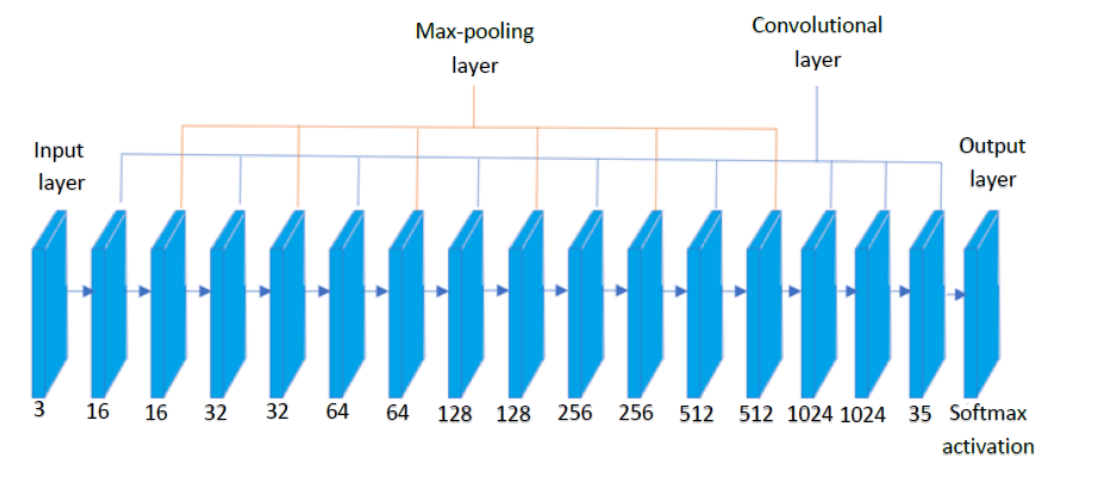
Figure 2. Convolutional Neural Network (CNN)